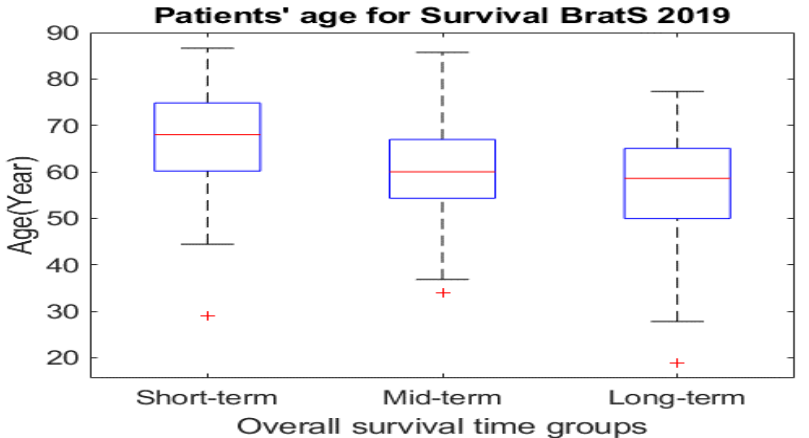
Figure 4. Boxplot of patients’ age for the three survival groups.